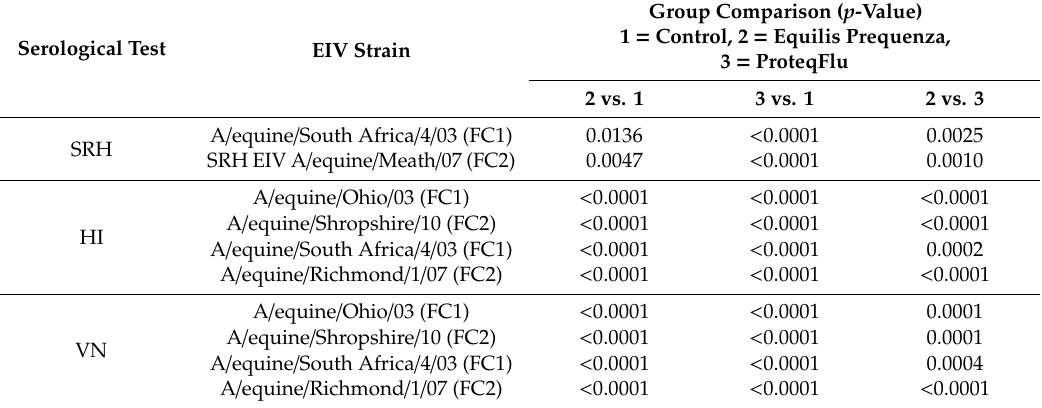
Table 3. Inferential statistics: Comparison of serological titres after challenge between groups (average of 155 and 162 dpv; 7 and 14